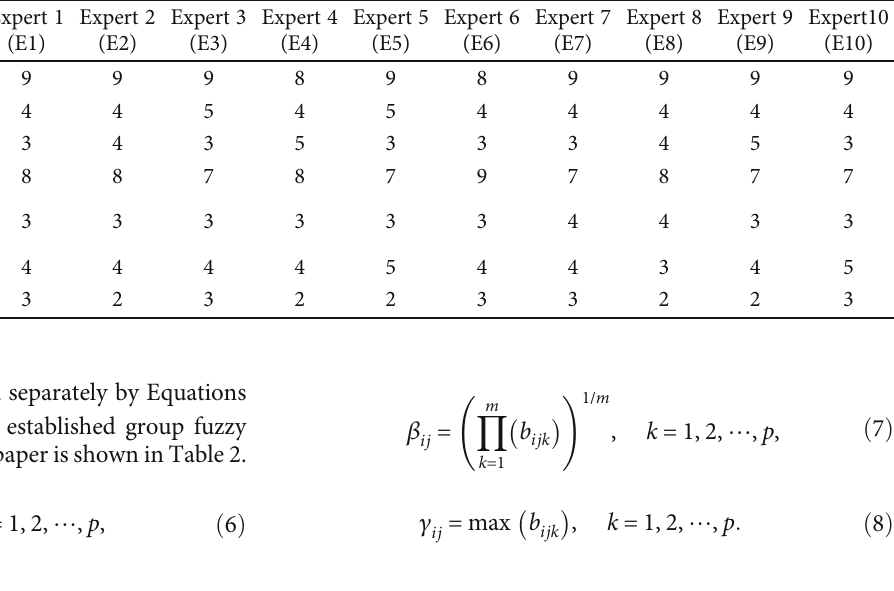
Figure 5: Flowchart of the methodology. Table 1: Relative importance matrix of evaluation